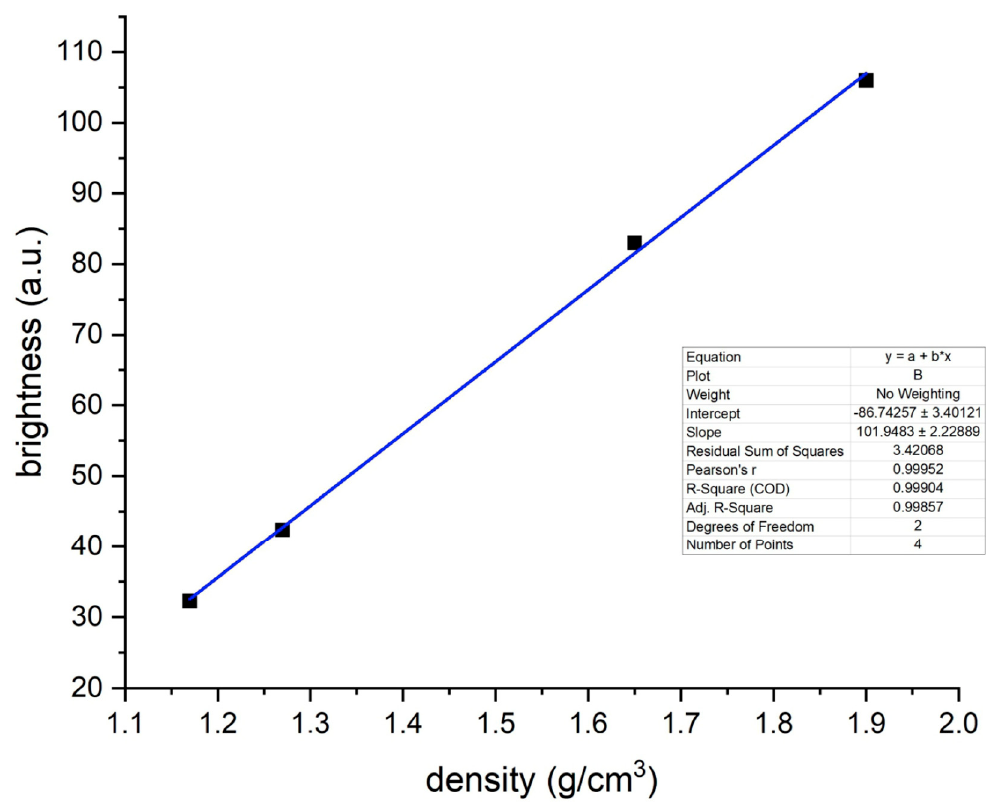
Figure 5. An example of a calibration curve for the density of template bars, together with the parameters of a linear function necessary to identify the density of dentin in premolars 1–5. Table 5. Density of dentin and enamel for premolars and incisors.